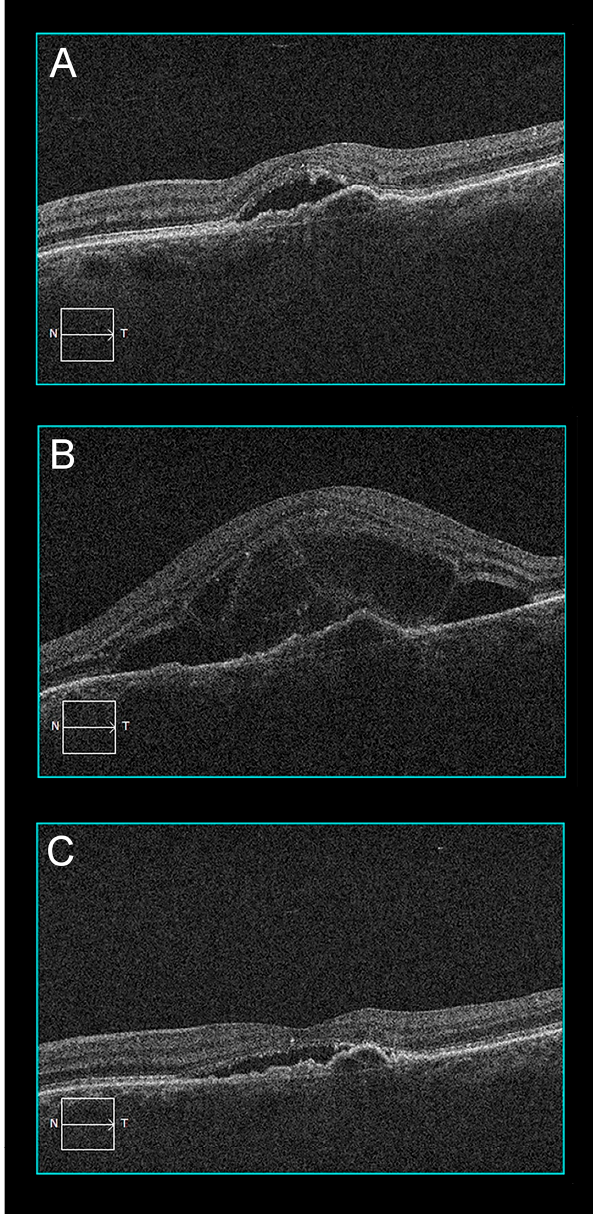
Figure 4. Patient 2 optical coherence tomography evolution before and after PDT: ( A ) Baseline OCT B-scan shows type 1 macular neovascularization with subretinal fluid; ( B ) two days after PDT, subretinal fluid increased substantially and a bacillary layer detachment was present; ( C ) after 2 months, there was a significant reduction of the subretinal fluid and the bacillary layer detachment had